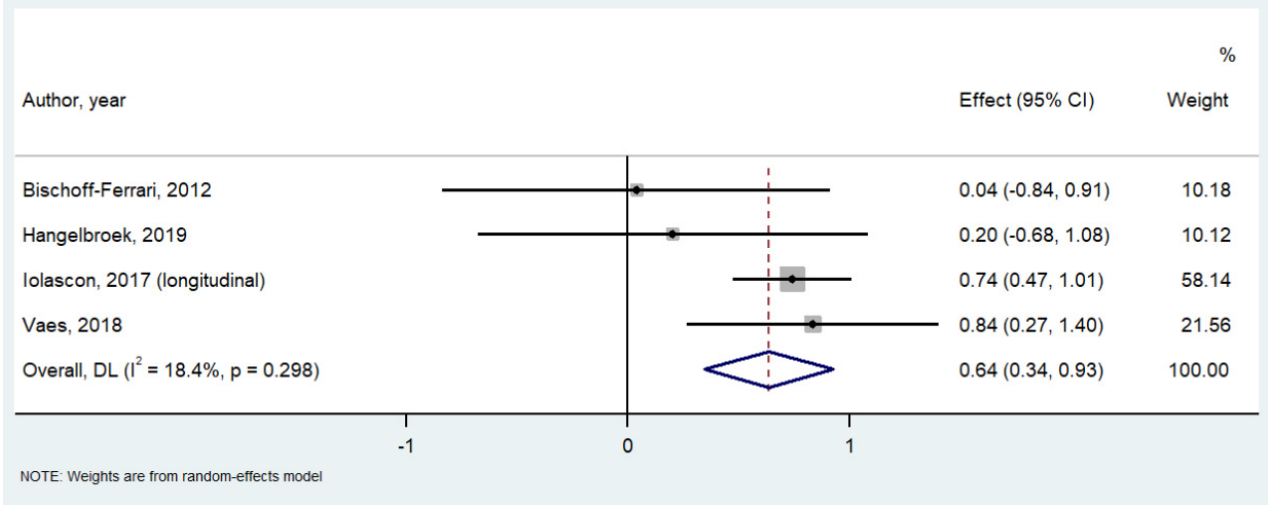
Figure 3. Forrest plot of the effect of calcifediol on leg extension. References [15,17,18,21]. No publication bias emerged for any test